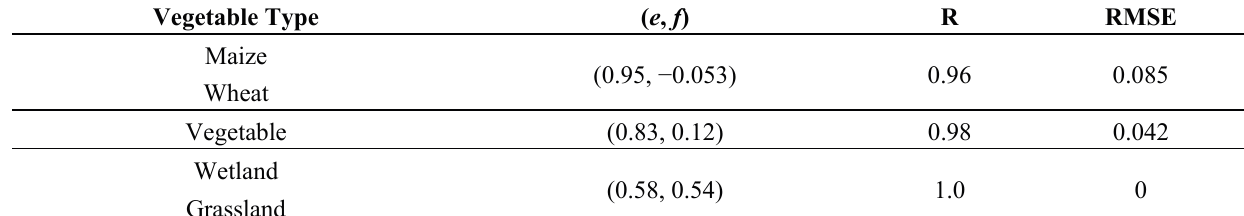
Table 6. The empirical parameters e and f in the h(LAI) relationship (Equation (8)) for different vegetation types.